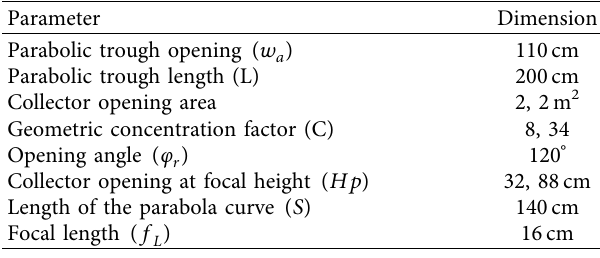
Table 1: PTSC geometric parameters.